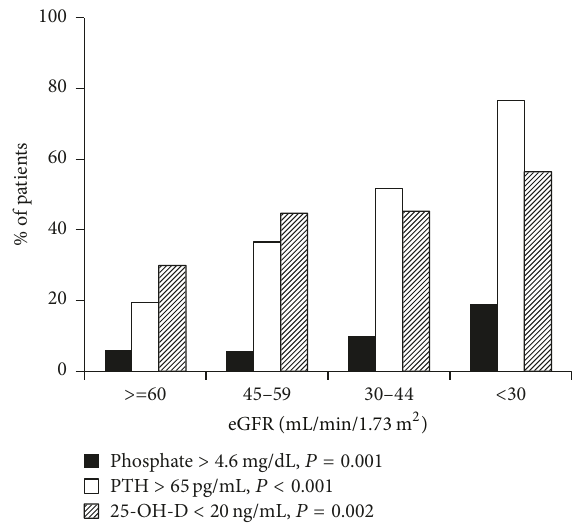
Figure 1: Prevalence of hyperphosphatemia according to kidney function . 𝑃 values represent the significance of trend. Reuse with permission from Chartsrisak et al. [3].